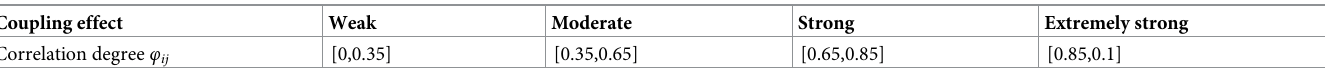
Table 4. Coupling strength and discrimination